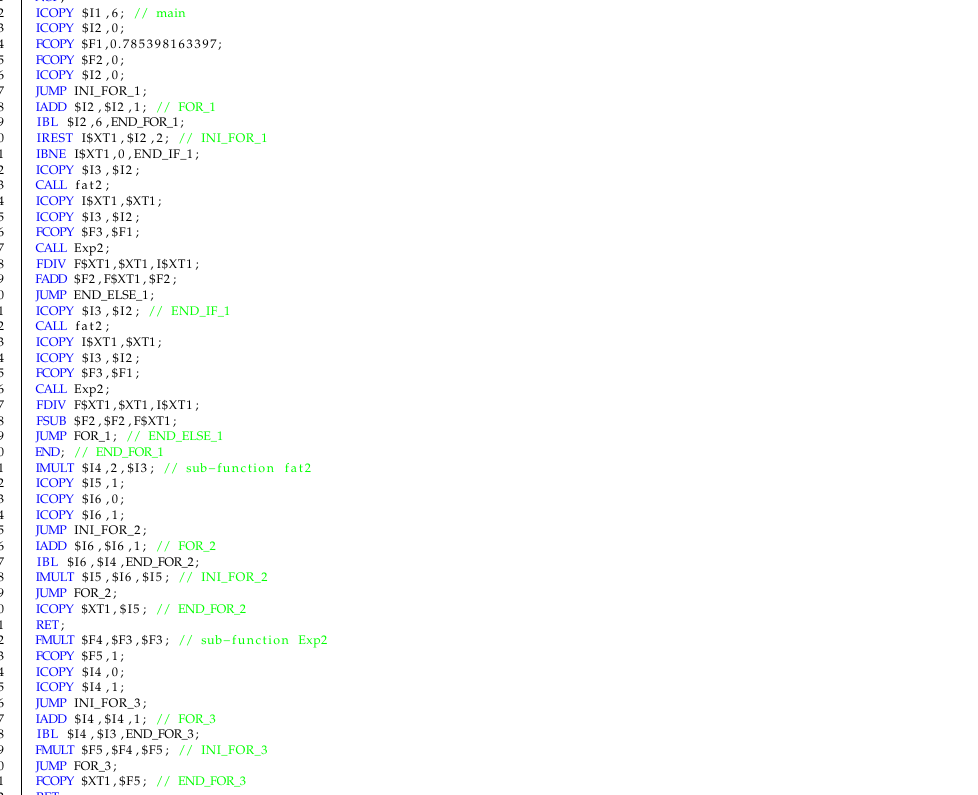
Algorithm 2: PAMPIUM assembly code for Algorithm